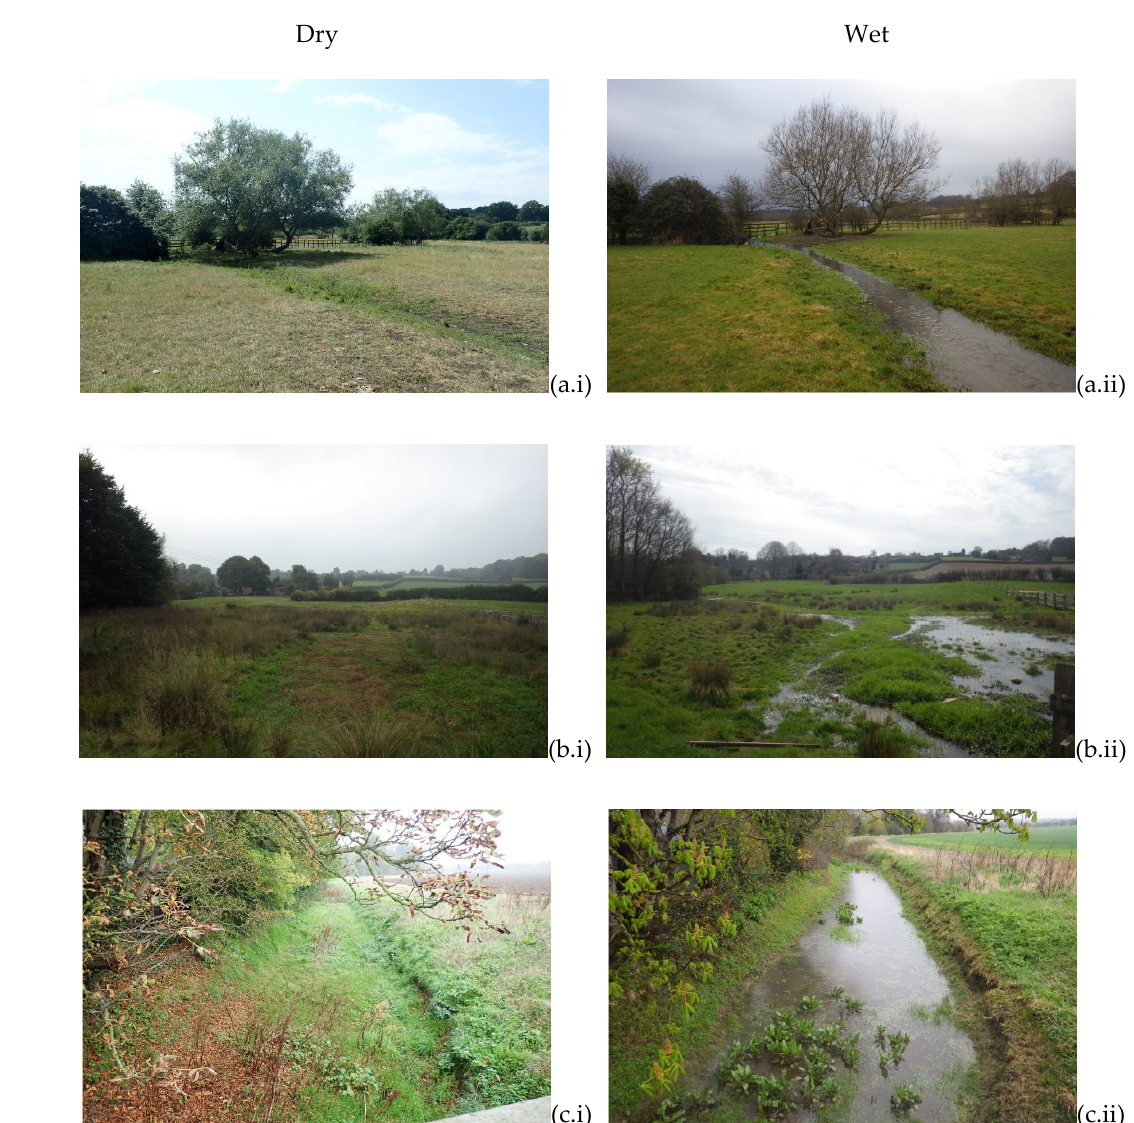
Figure 2. The Gade ( a ), Misbourne ( b ), and Ash ( c ) in dry ( i ) and wet ( ii ) phases. Photo credit: Environment Agency 2016–2019.